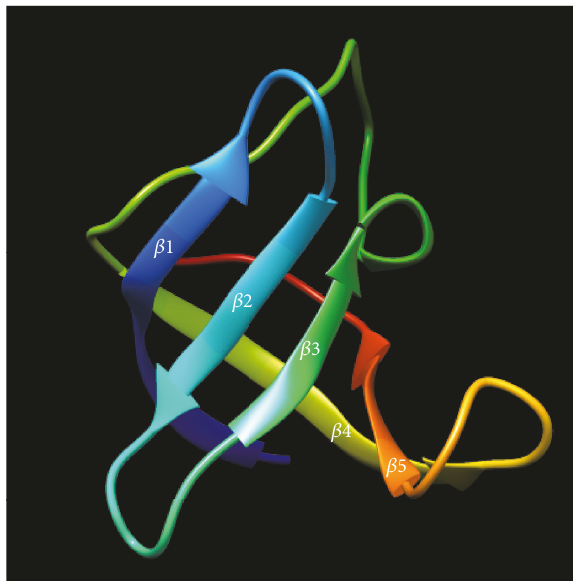
Figure 3: Modeled tertiary structure of Dm-Csp1 . The five anti-parallel strands that collectively form a barrel structure are indicated.